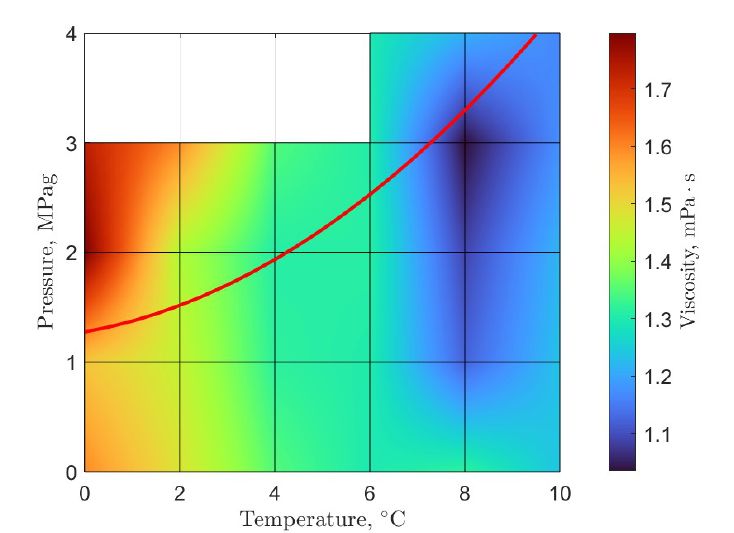
Figure 3. Rheological phase diagram of carbon dioxide gas hydrates: the viscosity of pre-nucleation and early hydrate formation systems overlayed with the three-phase hydrate-liquid-gas equilib- rium line (red line); equilibrium data from Carroll in Natural Gas Hydrates [3]; figure adapted from Guerra et al.